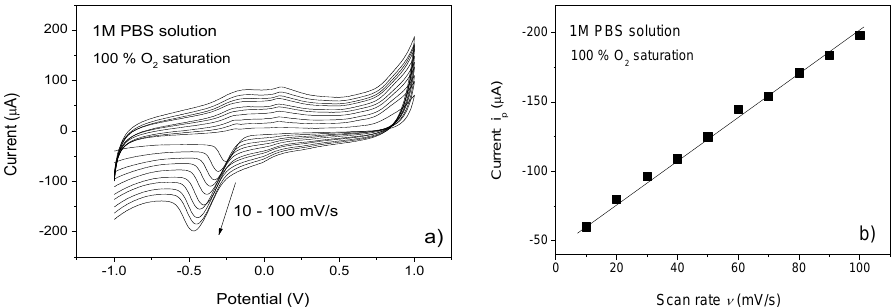
Figure 2. ( a ) Effect of scan rate (10–100 mV/s) on cyclic voltammetry response in an oxygen saturated solution; ( b ) correlation between the reduction peak and the scan rate.